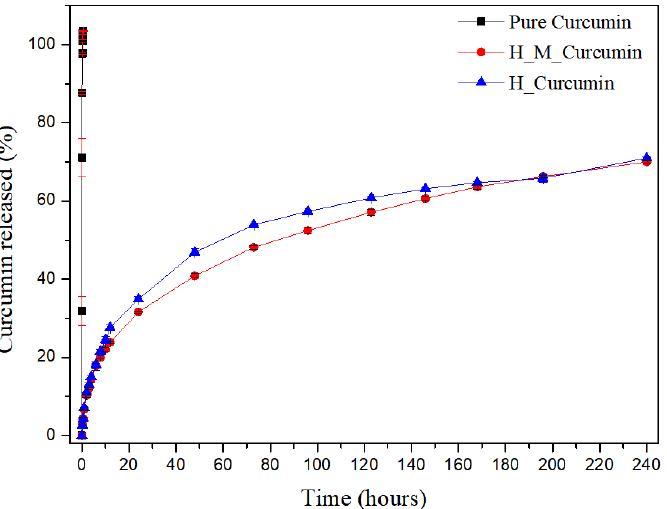
Figure 4. Release of curcumin present in a U-PEO material as a function of time. Accumulative release of curcumin as a function of time from pure curcumin (black line), U-PEO + curcumin (blue line) and U-PEO + micelle + curcumin (red line).